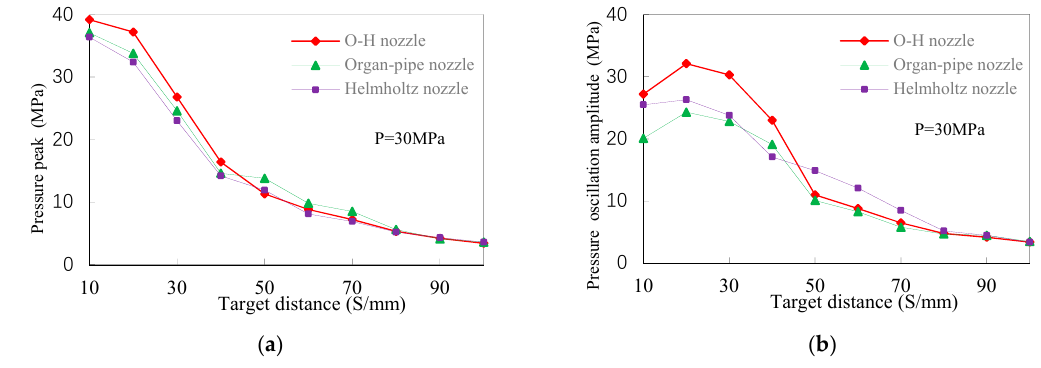
Figure 7. Performance comparison of three nozzles: ( a ). Comparison of pressure peaks at different axis target distances. ( b ). Comparison of pressure oscillation amplitude at different axis target distances.